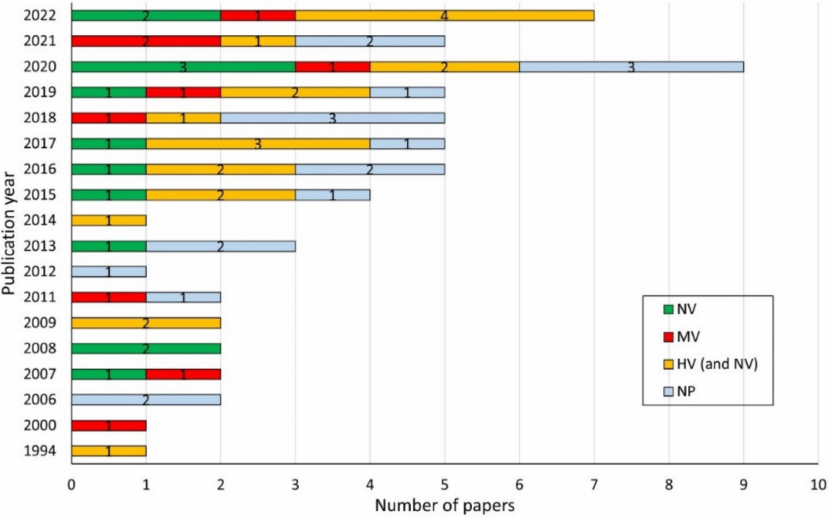
Figure 5. Association between ventilation type suggested and publication year. Numbers indicate the number of papers recommending each ventilation type. NV: natural ventilation; MV: mechanical ventilation; HV: hybrid ventilation; NP: no